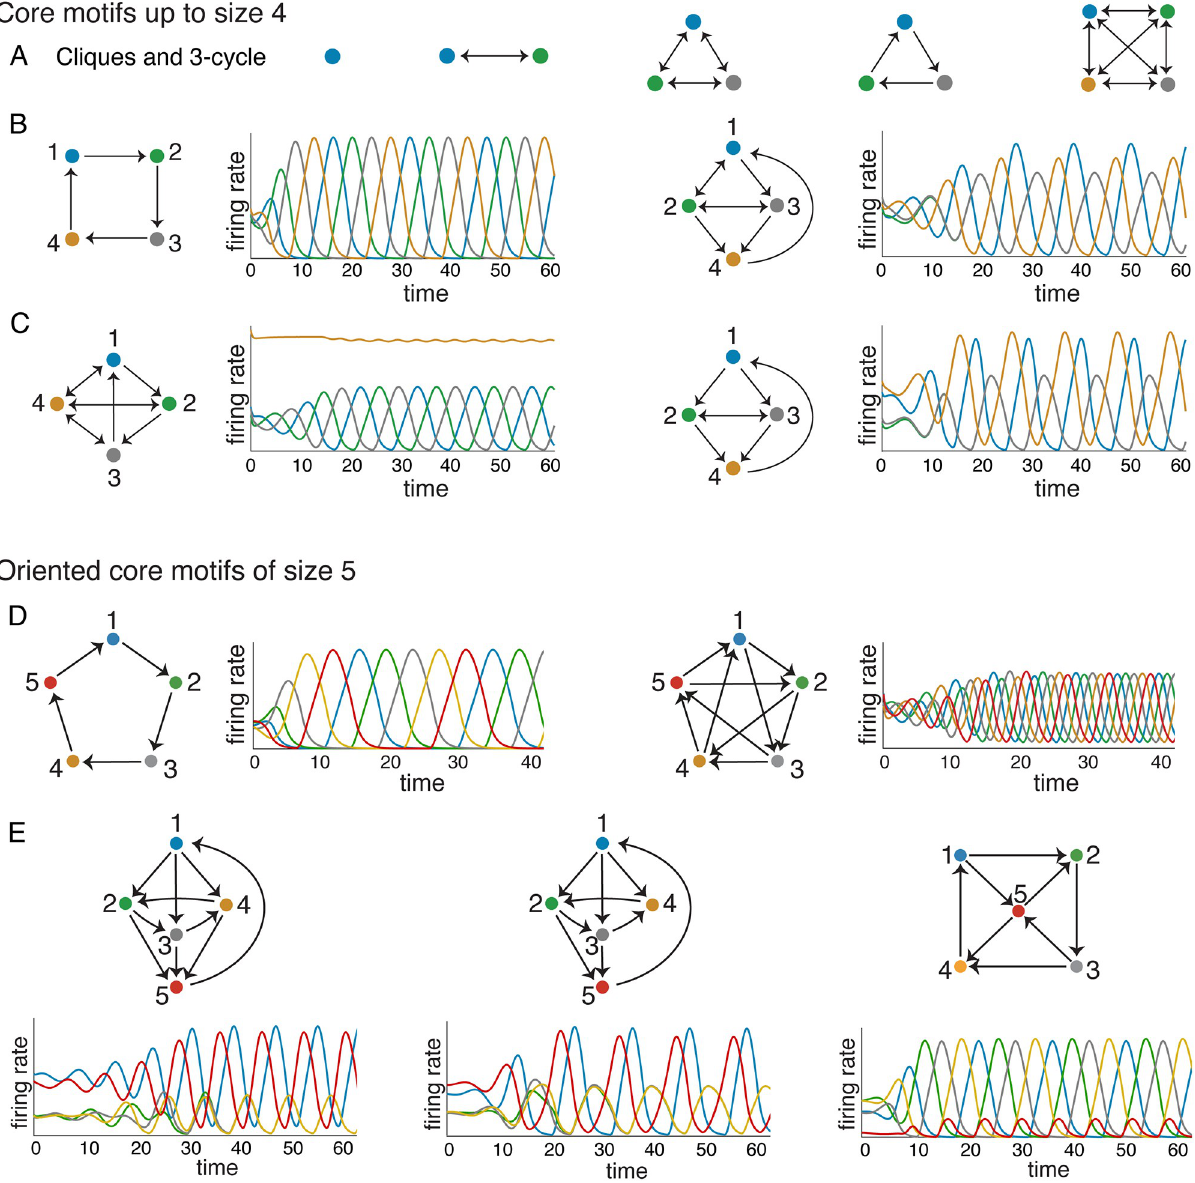
Fig 5. Core motifs. (A-C) All core motifs of size n � 4. Note that every clique is a core motif, as are all cycles. (B-C) Attractors are shown for each core motif of size 4 other than the 4-clique, whose attractor is a stable fixed point. (D-E) All n = 5 core motifs that are oriented graphs.